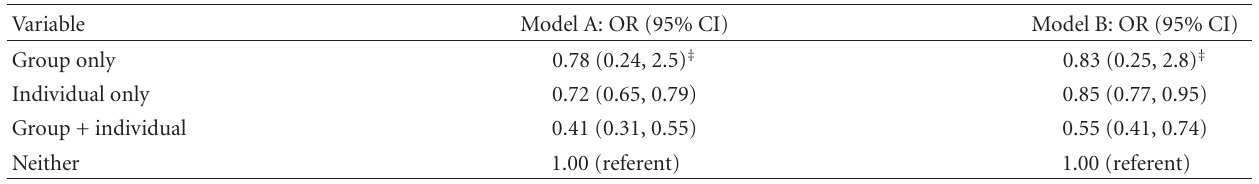
Table 2: Results of logistic regression analysis for the relationship between active environments and likelihood of having a mood disorder ( N =